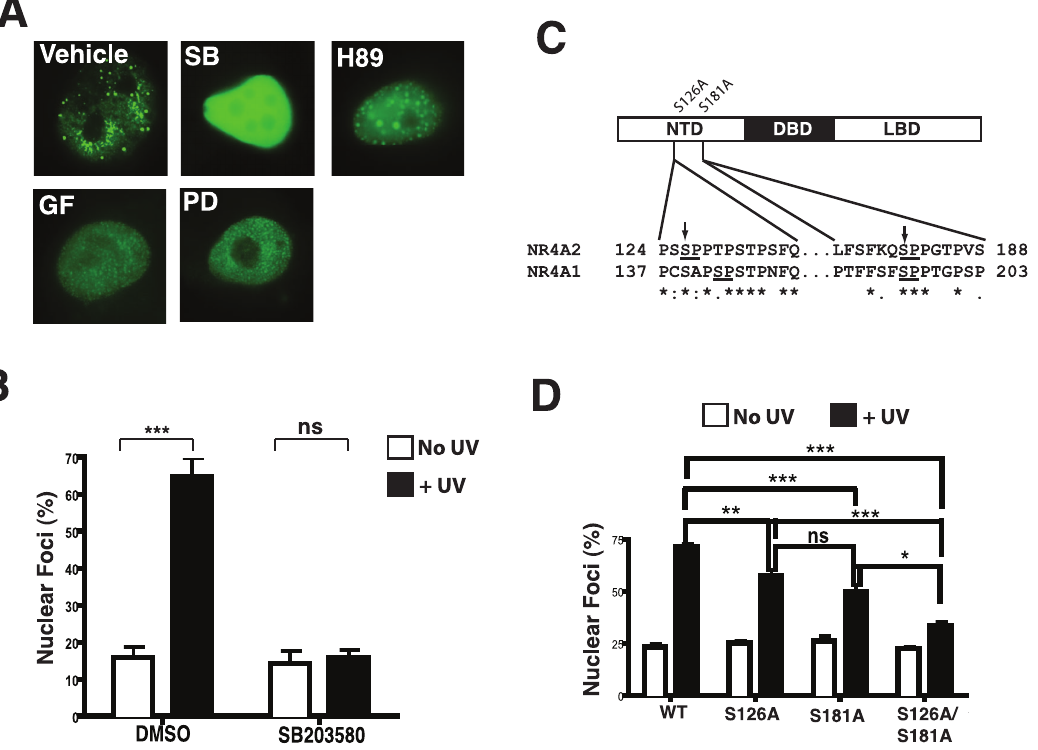
Figure 2. p38 signalling mediates UV induced localisation of NR4A proteins to sites of DNA damage repair. ( A ) Fluorescent images of EYFP-NR4A protein localisation in nuclei following UVR treatment in the presence of inhibitors of p38 (SB203580; SB), PKA (H89), PKC (GF109203X; GF) or MEK1/2 (PD98059; PD) or DMSO (Vehicle). Representative images from 4 independent experiments are shown. ( B ) Nuclear images were scored as diffuse or foci positive from vehicle and p38 inhibitor treatments described above in mock and UVR treated cells. Bar graph shows the mean percentage of foci positive cells ( + / 2 SEM). ( C ) Schematic representations of NR4A2 protein showing position of potential of Alanine substitutions at p38 phosphorylation sites in the N-terminal domain at amino acids S126 and S181. Clustal alignment below shows sequences flanking the serine residues (arrow head) and phospho sites (underlined). ( D ) Scoring of foci containing nuclei in cells expression WT and S126A, S181A and S126A/ S181A mutant proteins as indicated. Bar graph represents the mean + / 2 SEM of results from 4 independent experiments. Statistical analysis in panels (B) and D was performed using ANOVA with a Tukey’s post-test (***, p , 0.0001; **, p , 0.001; *, p , 0.01; ns, not significant).